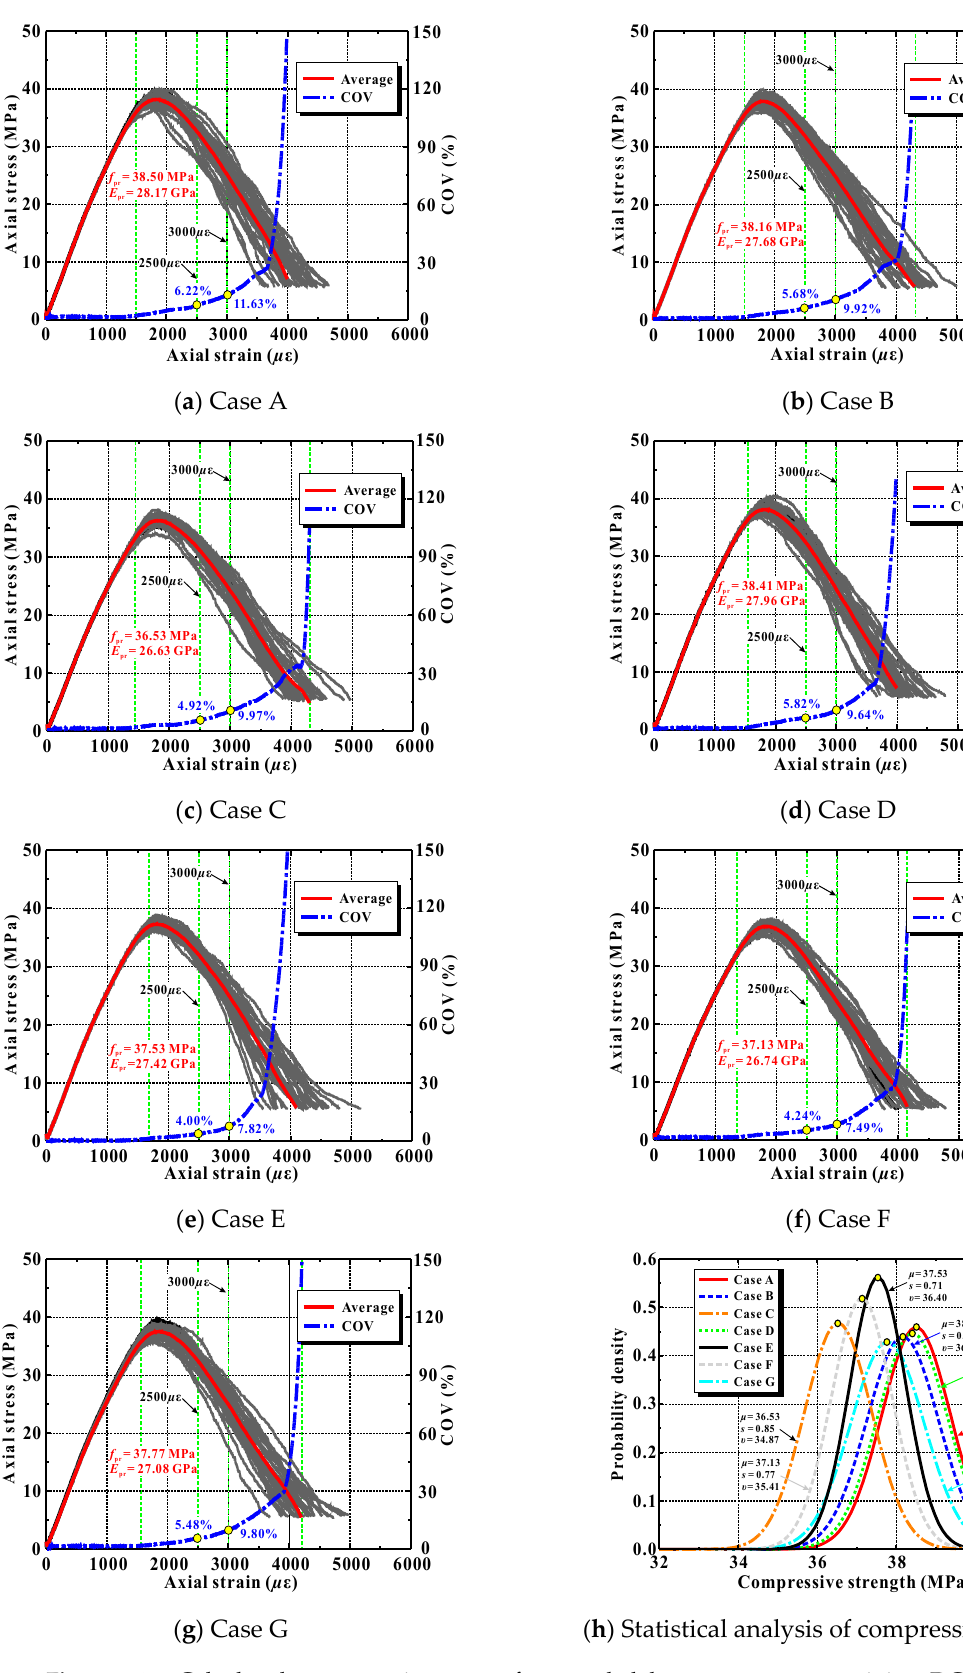
Figure 14. Calculated stress–strain curves for recycled lump concrete containing DCLs with different shapes.